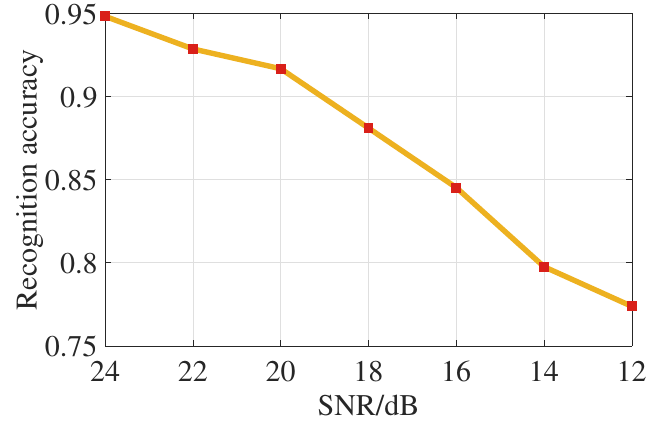
Figure 10. Average recognition accuracy at different